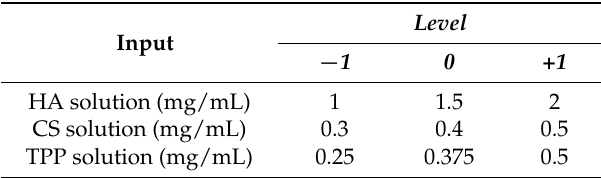
Table 2. Selected inputs and relative levels for the screening